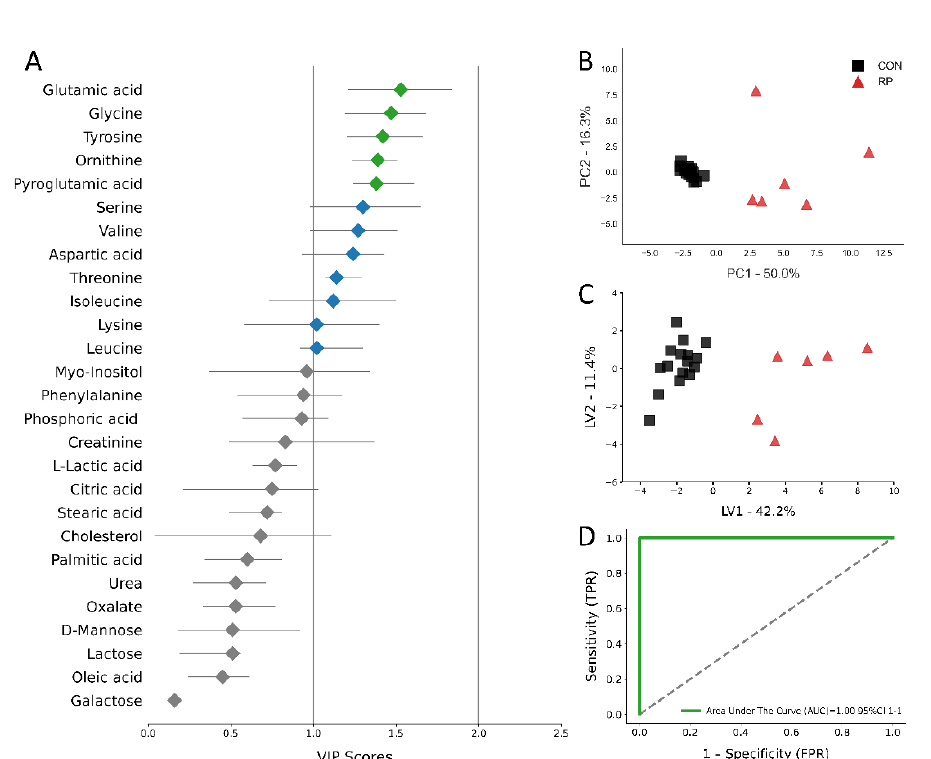
Figure 4. ( A ) Variables ranked by variable importance in projection (VIP), ( B ) PCA, ( C ) PLS-DA (permutation test: p < 0.05) of 16 healthy control (CON) cows and 6 cows pre- RP cows at −8 weeks prior to parturition. ( D ) ROC curve for five top- performing metabolites in Vip Scores.